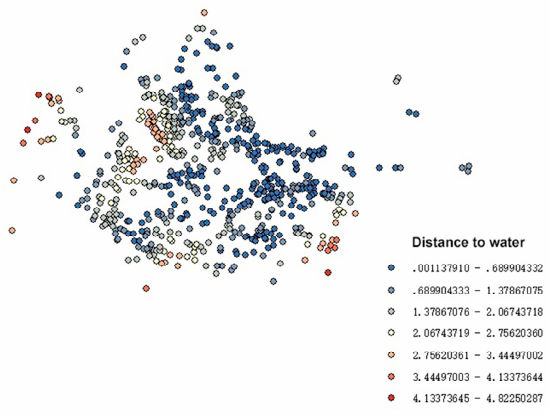
Figure 4. The distribution of distance to water system.